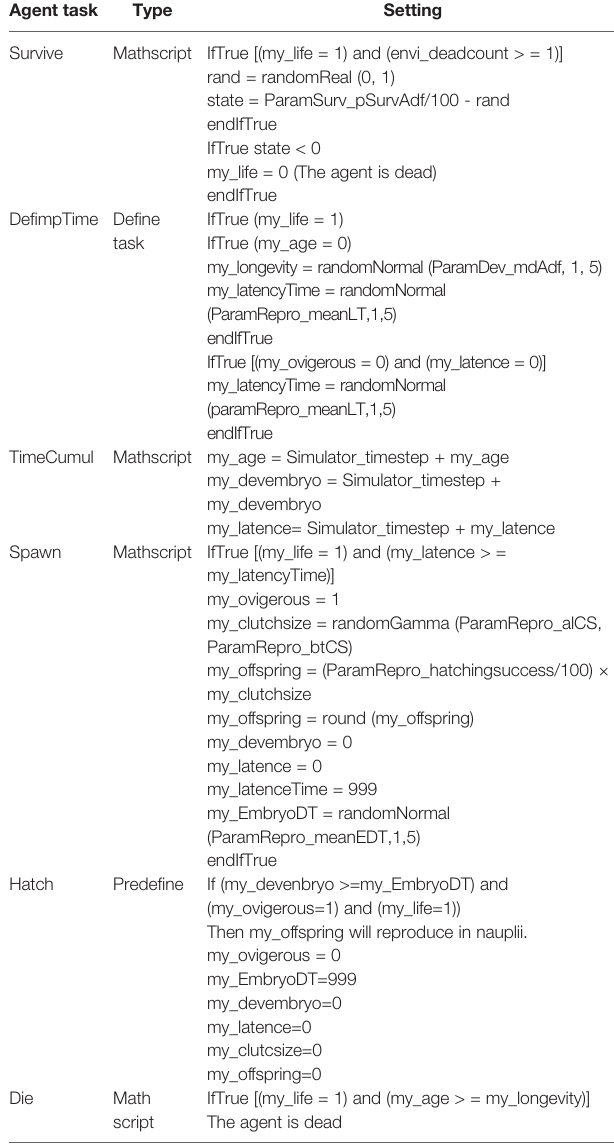
TABLE 3 | Settings of the tasks used to develop the reproductive cycle of an adult female of the copepod Apocyclops royi . Agent task Type Setting